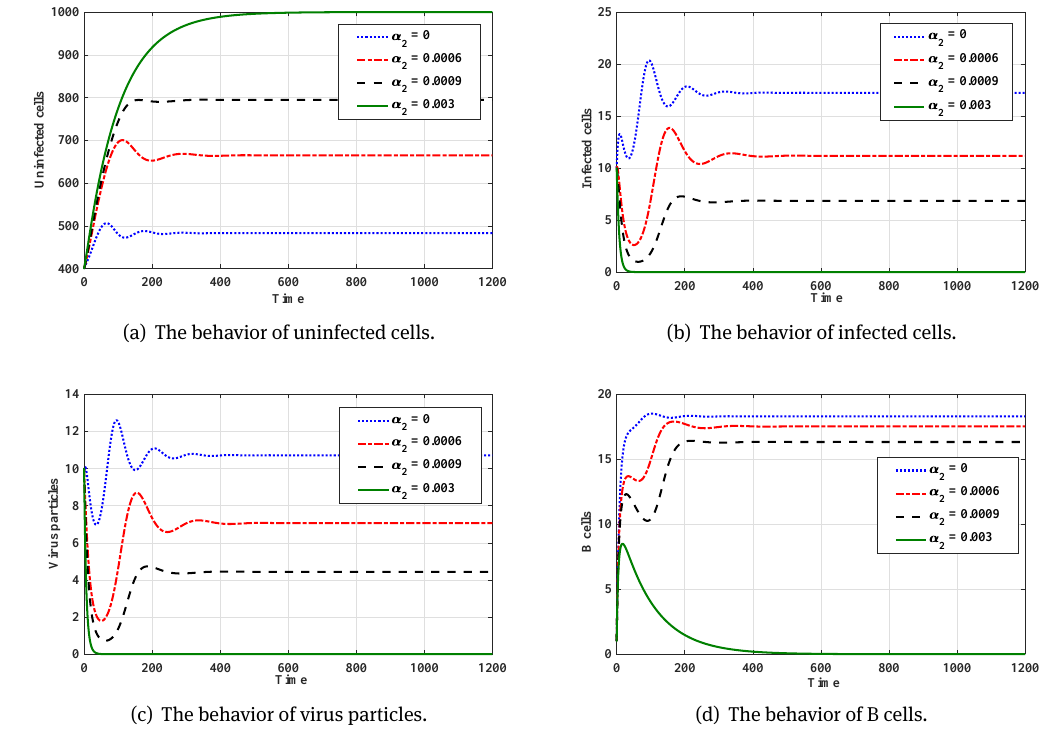
Figure 3: Solution trajectories of system (31)-(34) for different values of α 2 when α 1 = 0 .